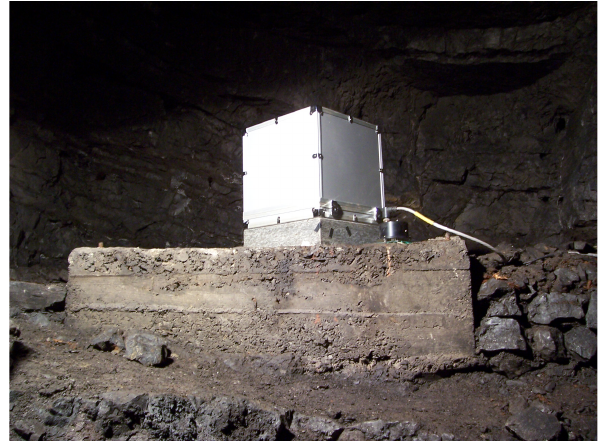
Fig. 3. Cludinico Station (CLUD): thermal insulation of the seis- mometer with aluminium box.